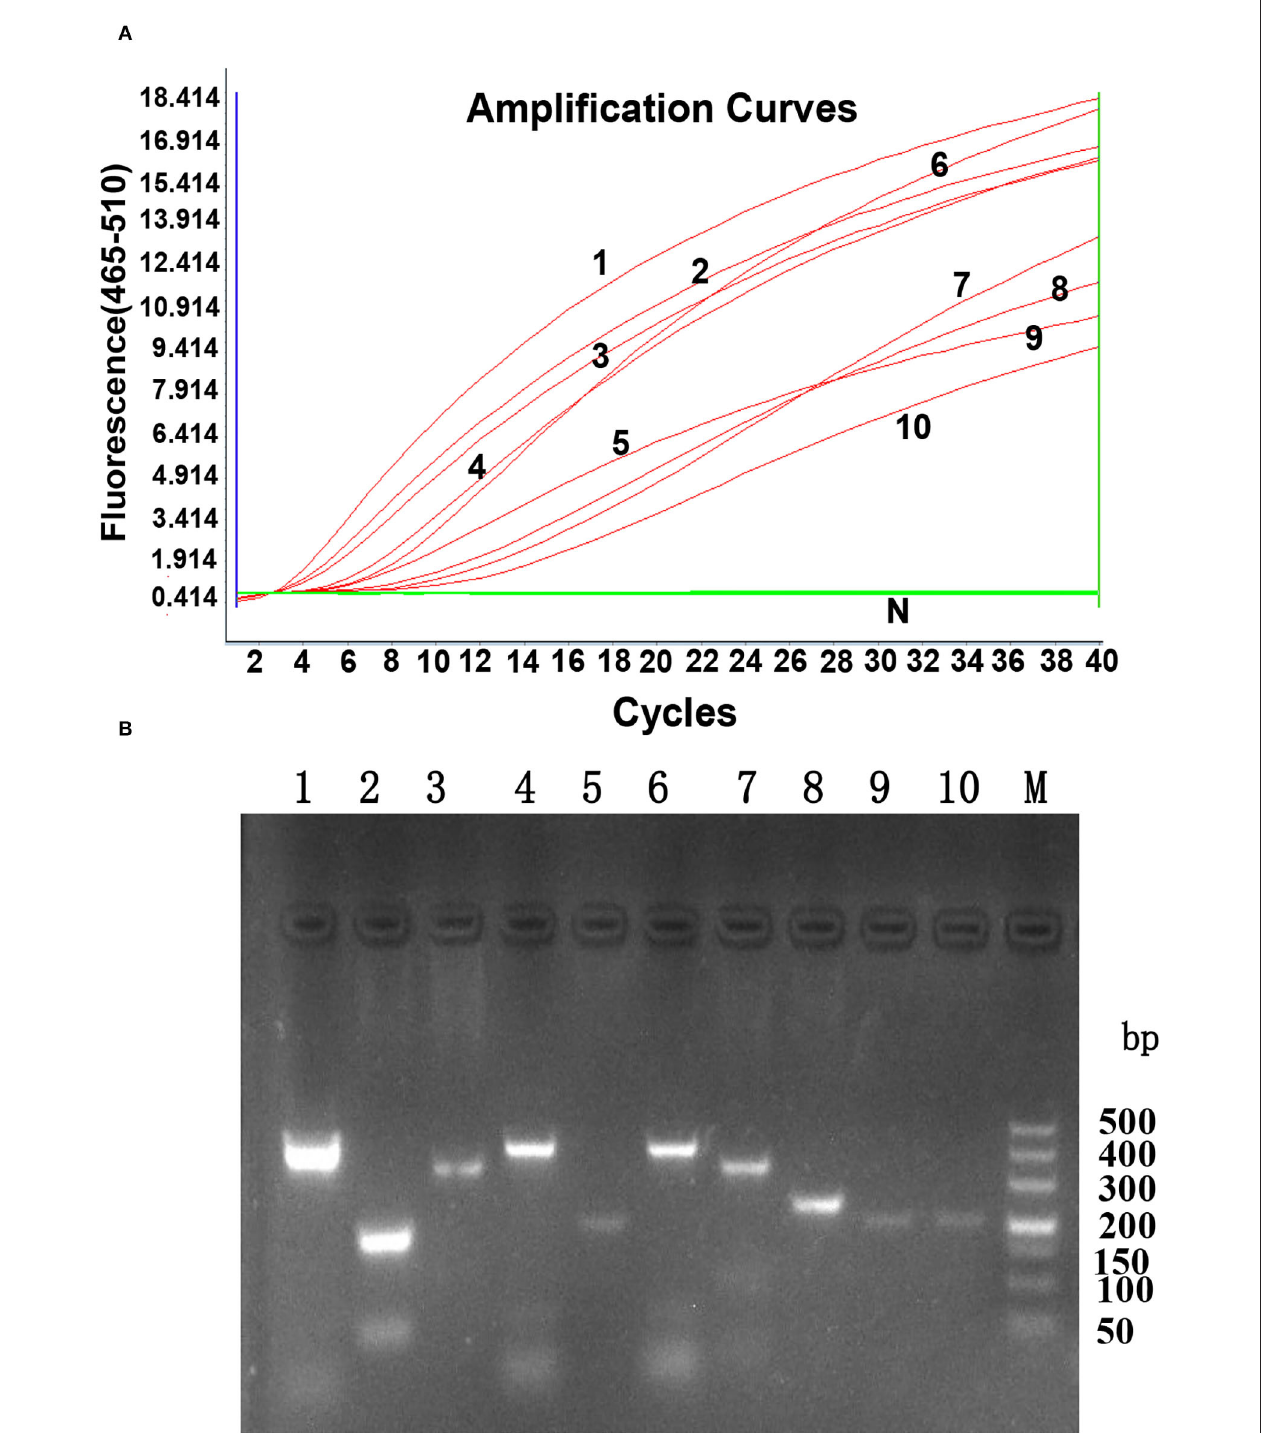
FIGURE 1 | The generated amplification plot for different combinations of primers and probes in real-time RPA. (A) . Amplification curve by LightCycler 480 Instrument II. N: Negative control; 1: ALV-J F1-R1; 2: ALV-J F1-R2; 3: ALV-J F1-R5; 4: ALV-J F2-R1; 5: ALV-J F2-R2: 6: ALV-J F2-R3; 7: ALV-J F3-R3; 8: ALV-J F3-R4; 9: ALV-J F3-R5; 10: ALV-J F3-R1. Reactions were scored positive when the change in fluorescence exceeded 1.0 units. (B) . Nucleic acid detection on agarose gel electrophoresis. 1: ALV-J F1-R1; 2: ALV-J F1-R2; 3: ALV-J F1-R5; 4: ALV-J F2-R1; 5: ALV-J F2-R2: 6: ALV-J F2-R3; 7: ALV-J F3-R3; 8: ALV-J F3-R4; 9: ALV-J F3-R5; 10: ALV-J F3-R1; M: DL500 DNA